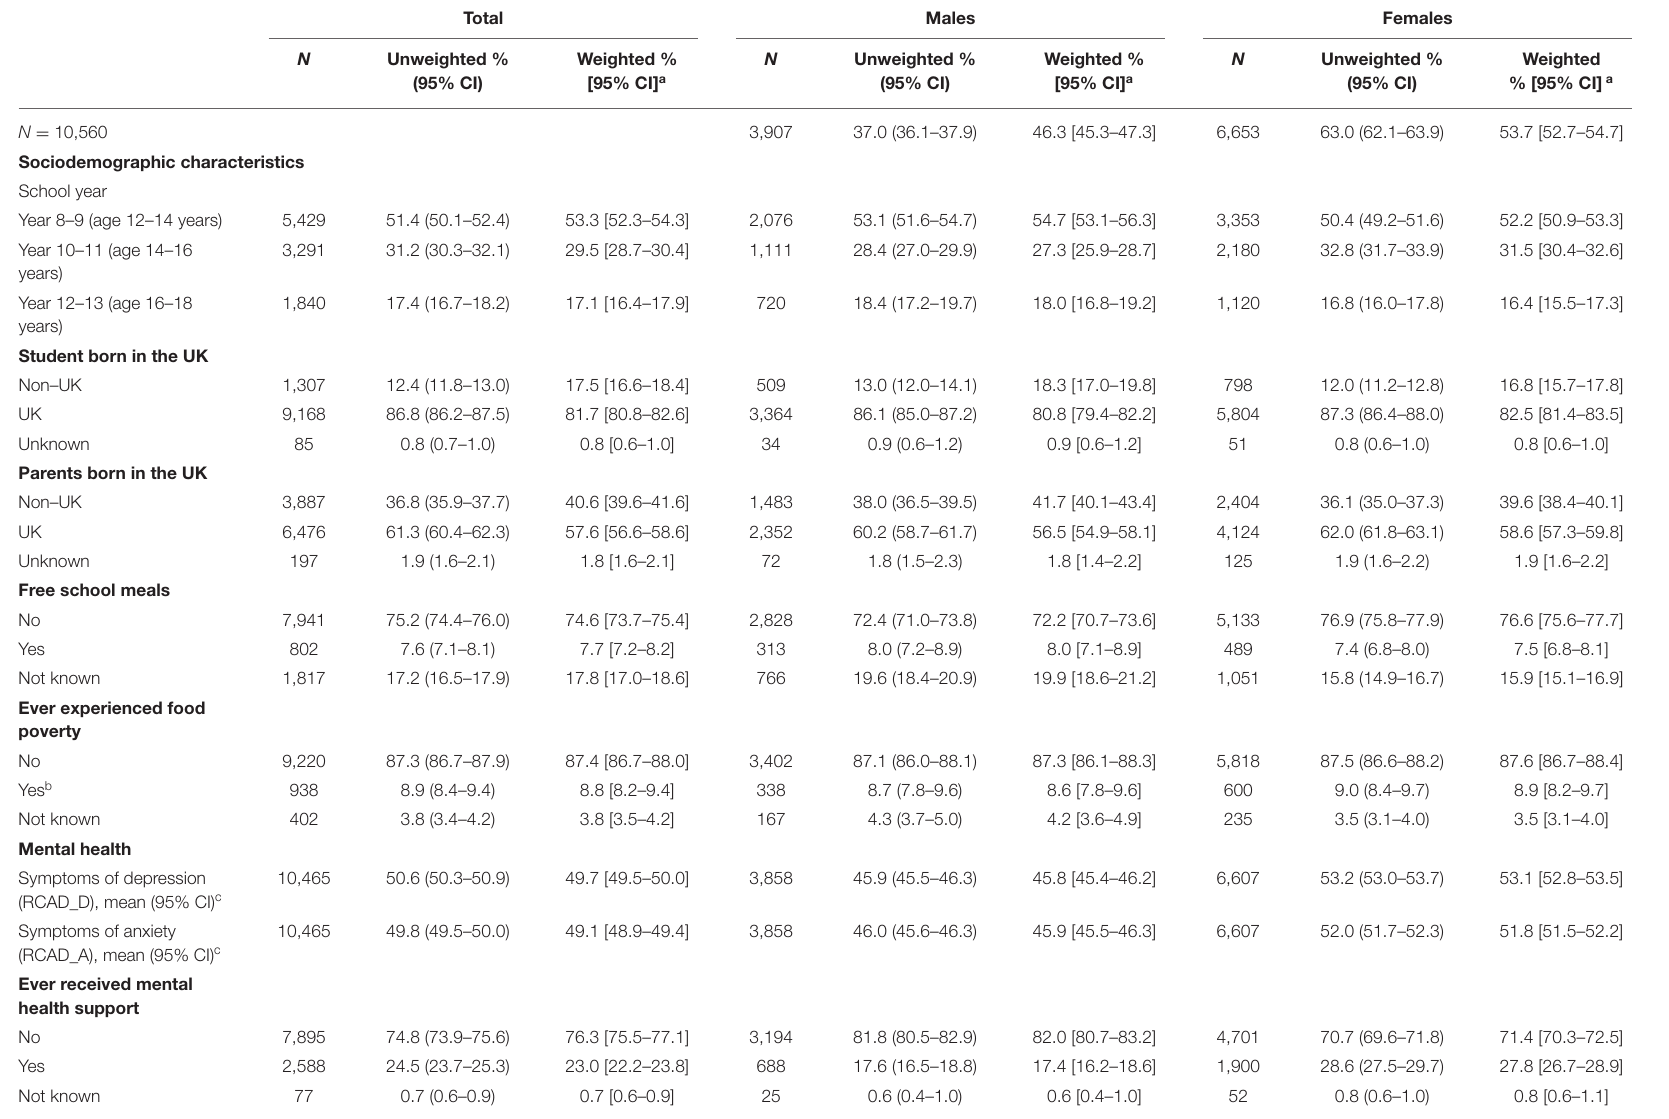
TABLE 1 | Characteristics of the analytic sample, unweighted and weighted proportions with 95% confidence intervals, by gender. Total Males